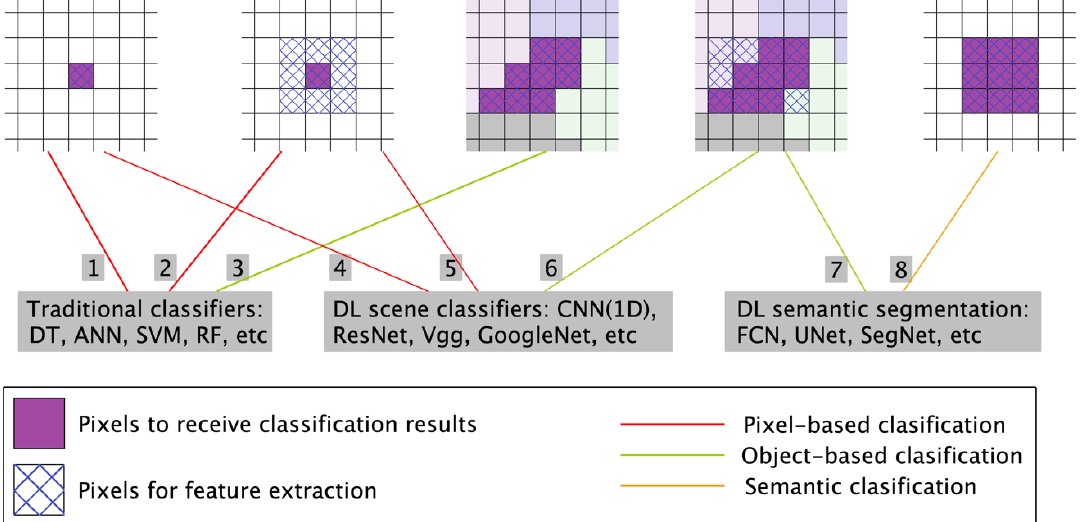
Figure 2. An overview of existing land cover classification paradigms in terms of their analysis unit. Purple color represents the classification result assignment area, oblique grid denotes the feature extraction area and different colors in the third and fourth grids represent different objects in the object-based image analysis. Different paths connecting different categories of classifiers and grids are numbered and will be referred to as Path-# when discussed in text.